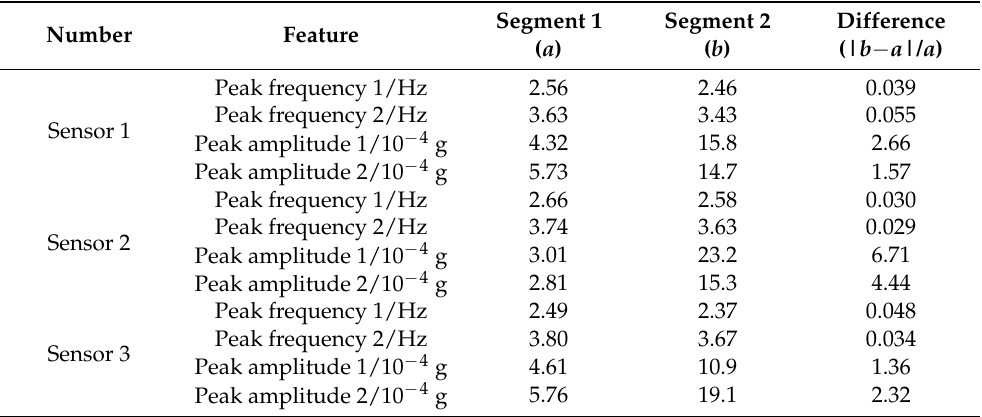
Table 4. Deviation of peak frequencies and amplitudes.